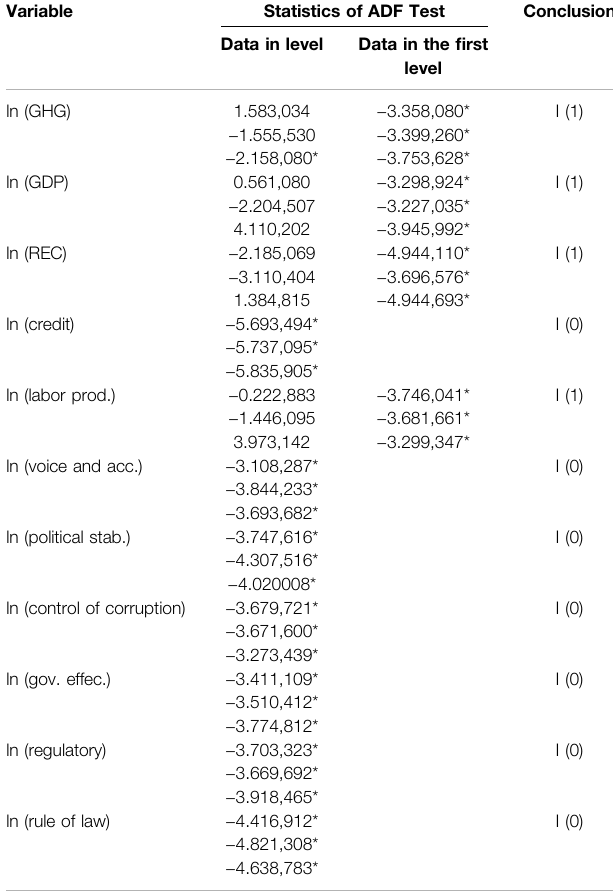
TABLE 2 | The results of unit root